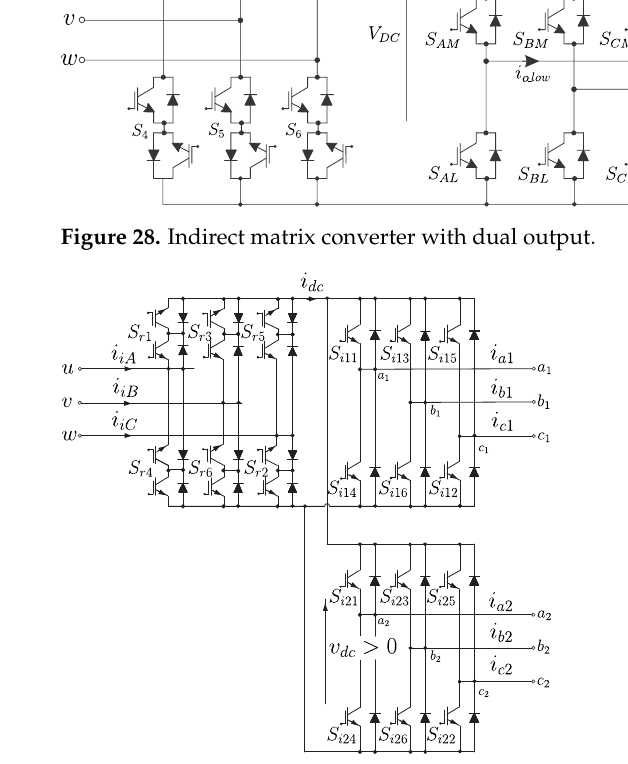
Figure 29. Multi-drive indirect matrix